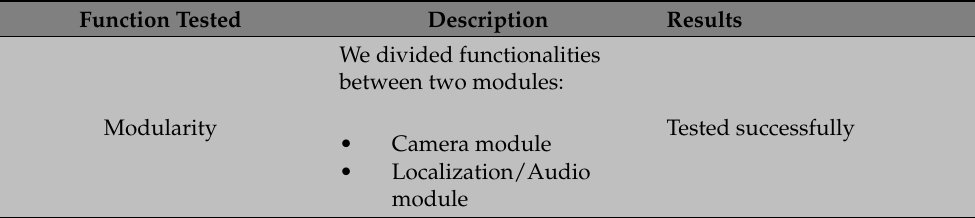
Table 2. Summary of the second round of